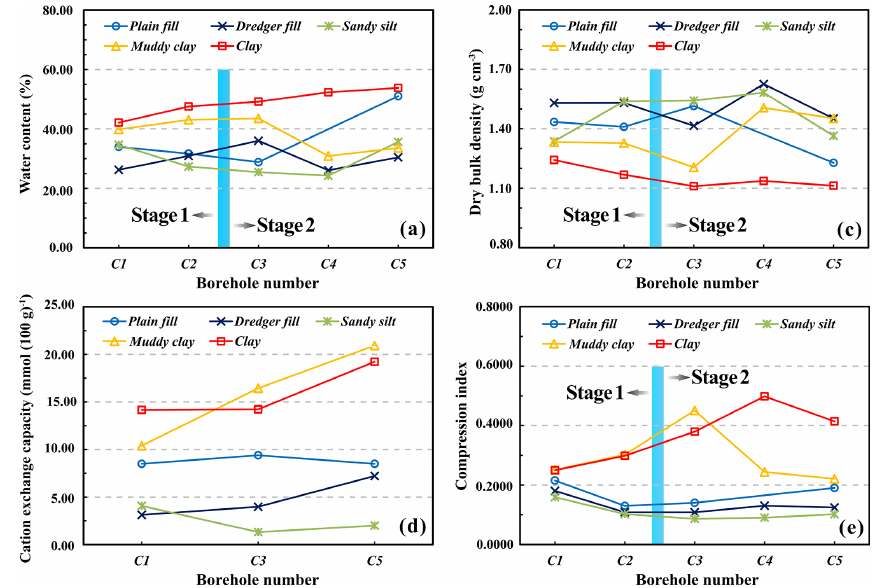
Figure 5. Variation of geological features of soil in dredger fill area in different phases from west to east.